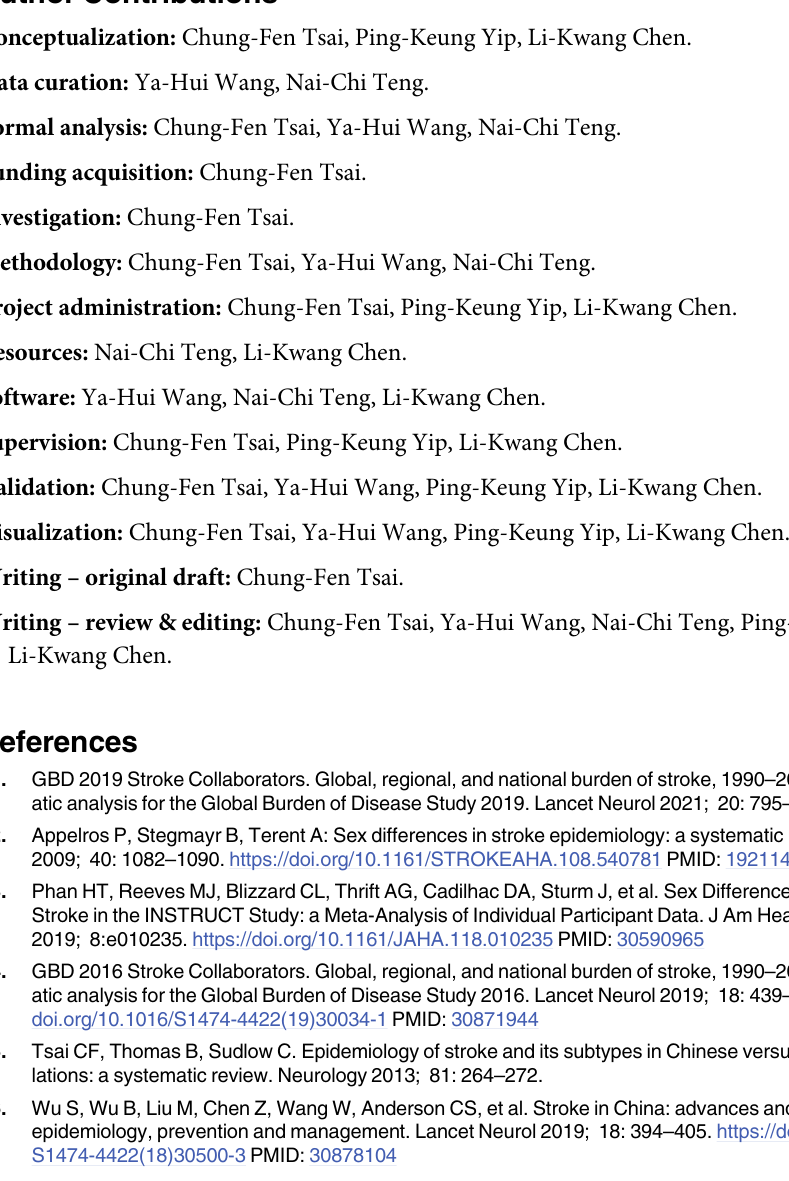
S1 Fig. Inclusion of acute stroke patients. S2 Fig. Secular trends of intracerebral hemorrhage to ischemic stroke incidence